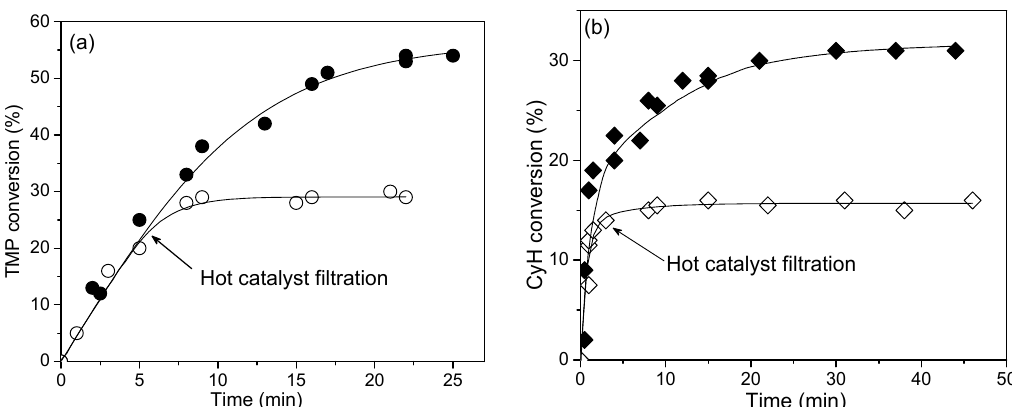
Figure 7. Hot catalyst filtration tests for ( a ) 2,3,6-trimethylphenol (TMP) oxidation over MIL-125 and ( b ) CyH oxidation over UiO-66 in the presence of 1 equiv. HClO 4 .